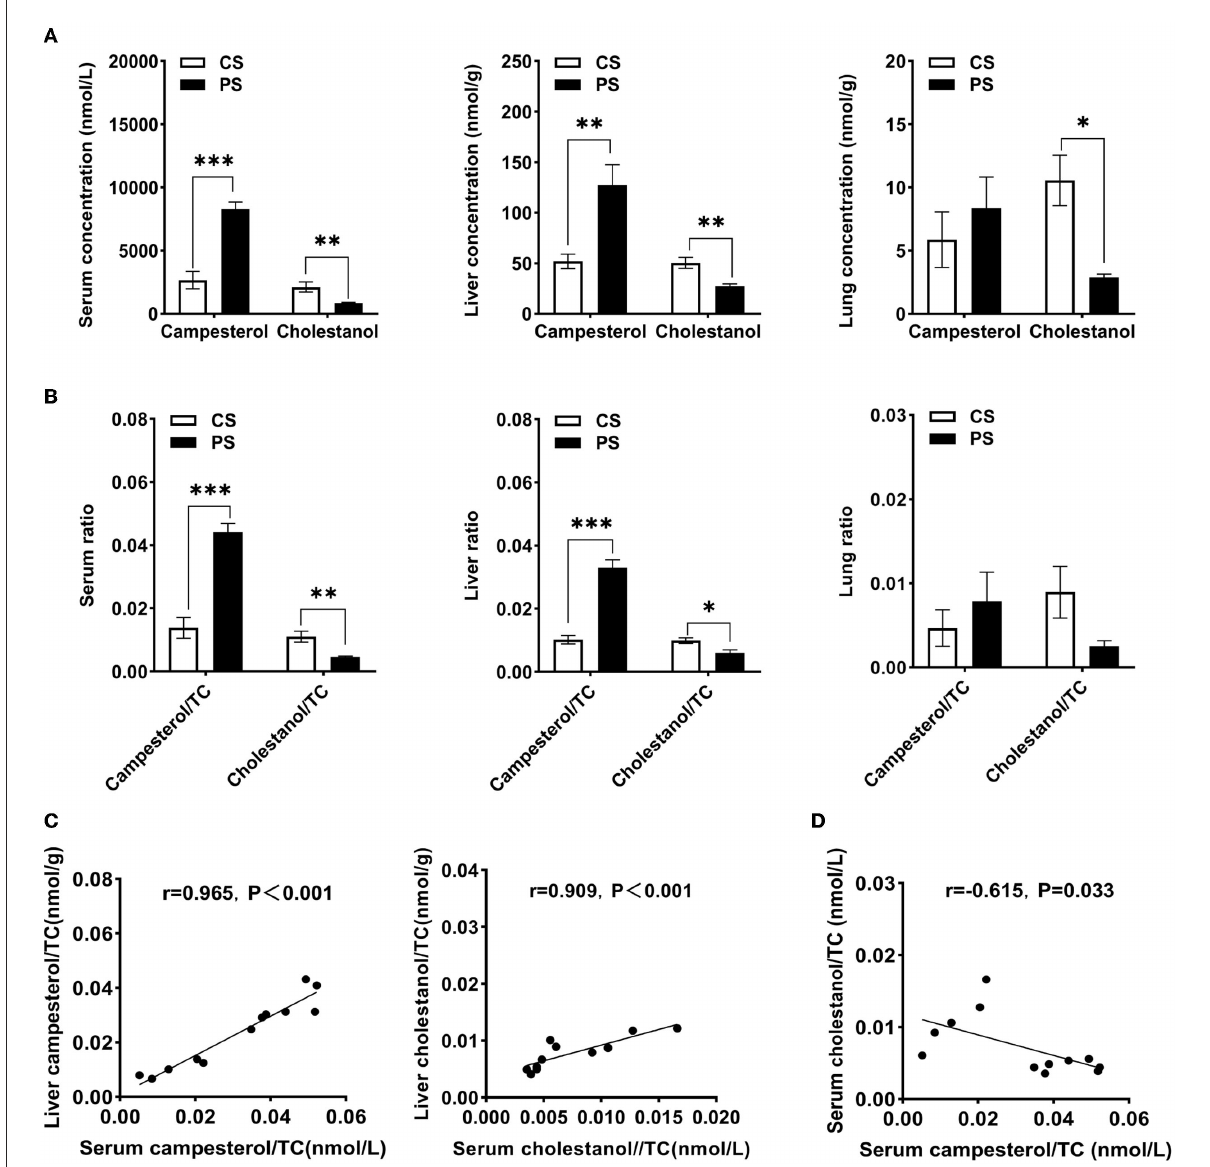
FIGURE1 Tissue-free sterols detection. (A) Concentrations of campesterol and cholestanol in serum (nmol/L), liver (nmol/g wet weight), and lung (nmol/g wet weight). (B) The ratios of campesterol and cholestanol concentrations to cholesterol in the serum, liver, and lung. (C) The correlation between hepatic and circulating campesterol/TC or cholestanol/TC. (D) The correlation between campesterol/TC and cholestanol/TC in serum. n = 5–7 mice/group. Results are shown as the mean ± SEM. * p < 0.05. ** p < 0.01, *** p <